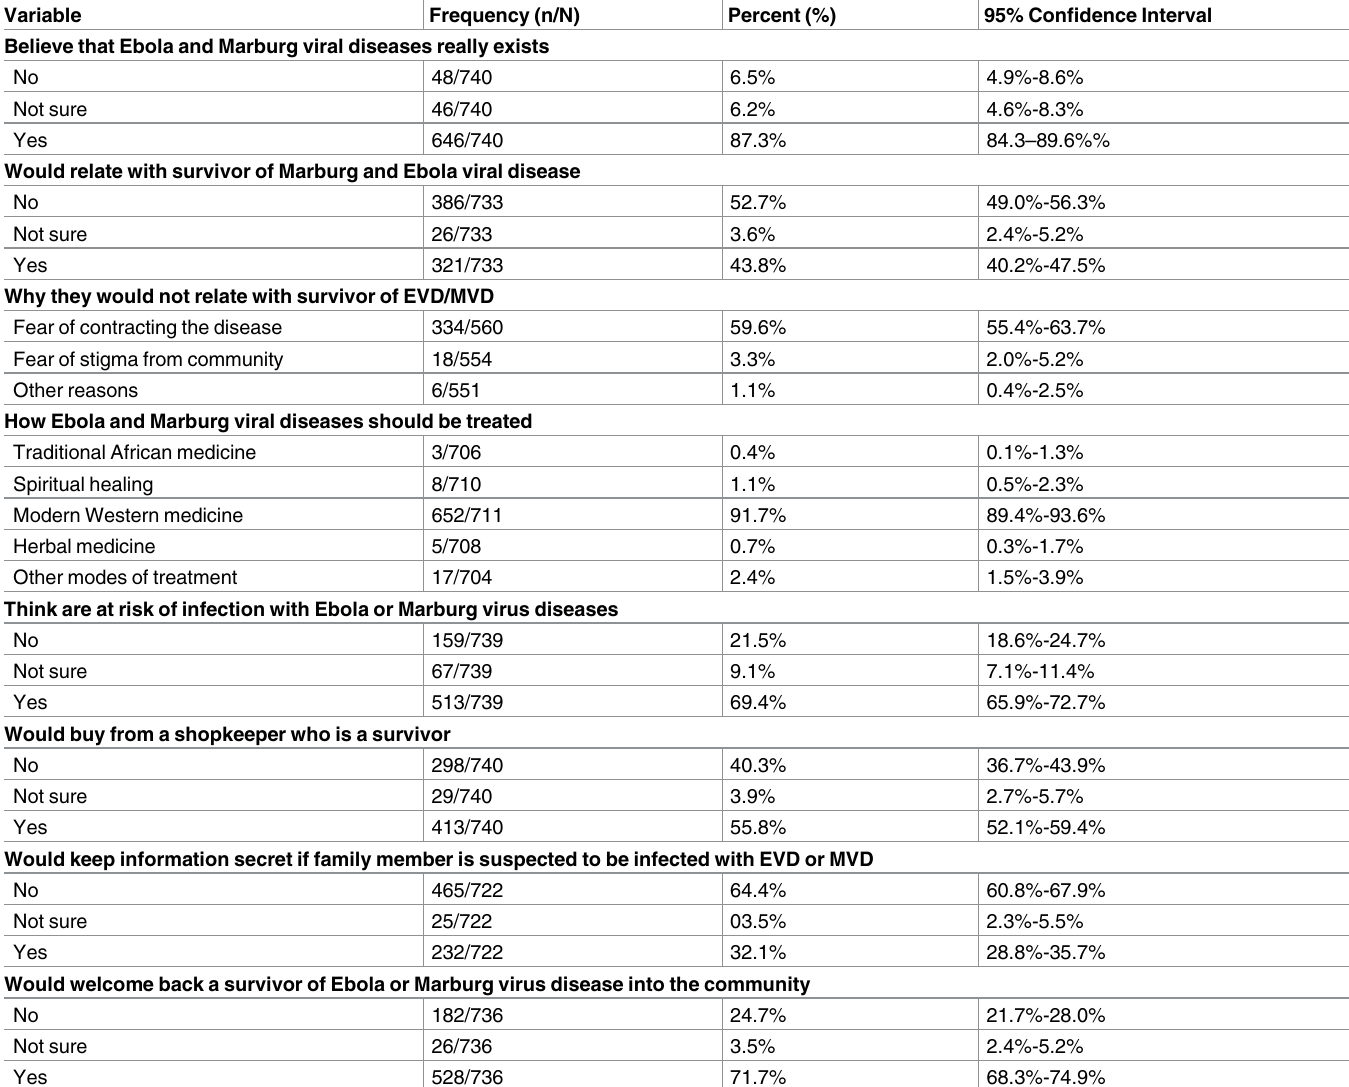
Table 3. Attitudes towards Ebola and Marburg viral